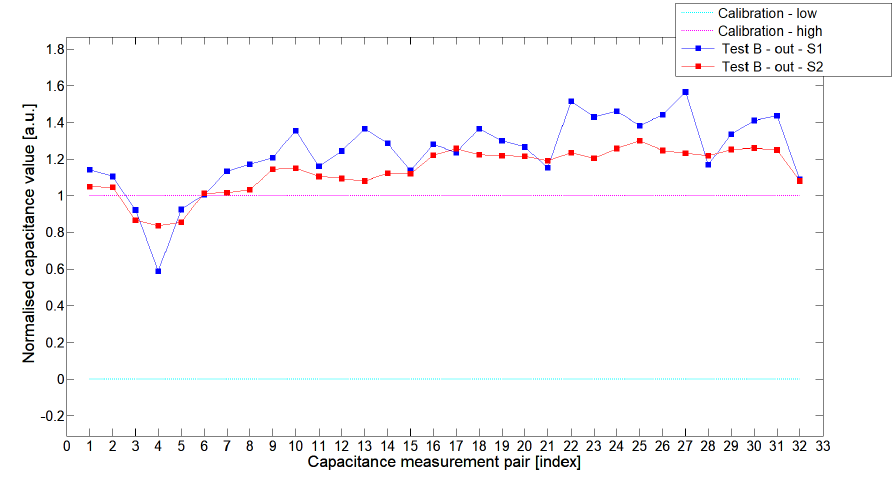
Figure 11. The 1st electrode measurement cycle (S1: 1->32 and S2: 1->32) for Test B out and S1—blue line, S2—red line. Cyan and magenta lines indicate calibration limits